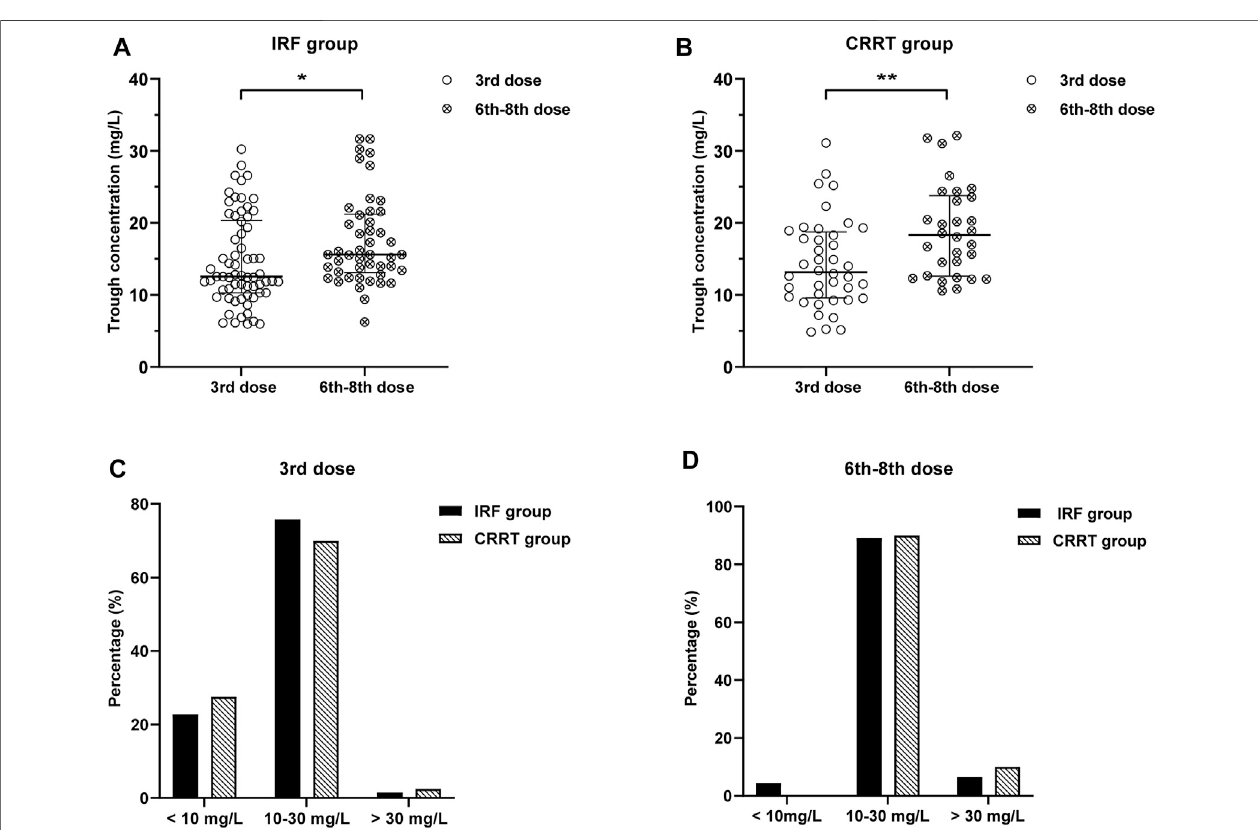
FIGURE 1 | (A,B) Distribution of TEI C min before the 3rd dose and the 6th – 8th dose in the IRF and CRRT groups. C min before the 6th – 8th dose was much higher thanthatbeforethe3rddoseintheIRFandCRRTgroups[16.2(13.4 – 22.1)mg/Lvs.12.9(10.7 – 20.8)mg/L, p =0.028;20.3(10.8 – 24.8)mg/Lvs.12.5(9.4 – 18.7)mg/L, p =0.004]. (C,D) Rates ofTEI C min before the3rddose and the6th – 8th dosein therange of10 – 30 mg/Lwere 75.8and 89.1% intheIRF group, and 70.0and 90.0% in the CRRT group, respectively.